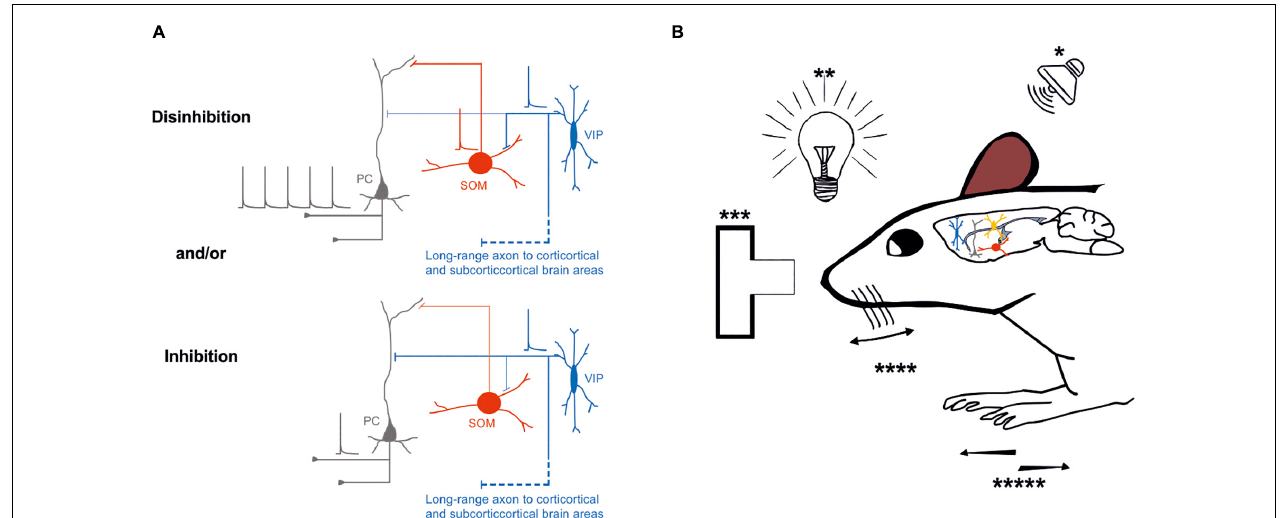
FIGURE 2 | Possible inhibitory and/or disinhibitory circuits are entrained during specific behavioral tasks. (A) Top left, Schematic representation of the disinhibitory circuit, in which the activity of an excitatory neuron (gray) is increased by the inhibitory effect of VIP-expressing neuron (blue) onto SOM–expressing neuron inhibition (red); bottom left, schematic representation of direct inhibition of the excitatory neuron (gray) by VIP-expressing neuron (blue). (B) External stimuli such as auditory (*), visual (**), decision making (***), whisking (****), or running (*****) entrain different circuits motive: inhibition or disinhibition of the excitatory neurons through the VIP-SOM microcircuit. Thick lines represent the axons that carries information and thin lines represent axons that are not active. Schematic action potentials are present depending on which neuronal circuit motive is